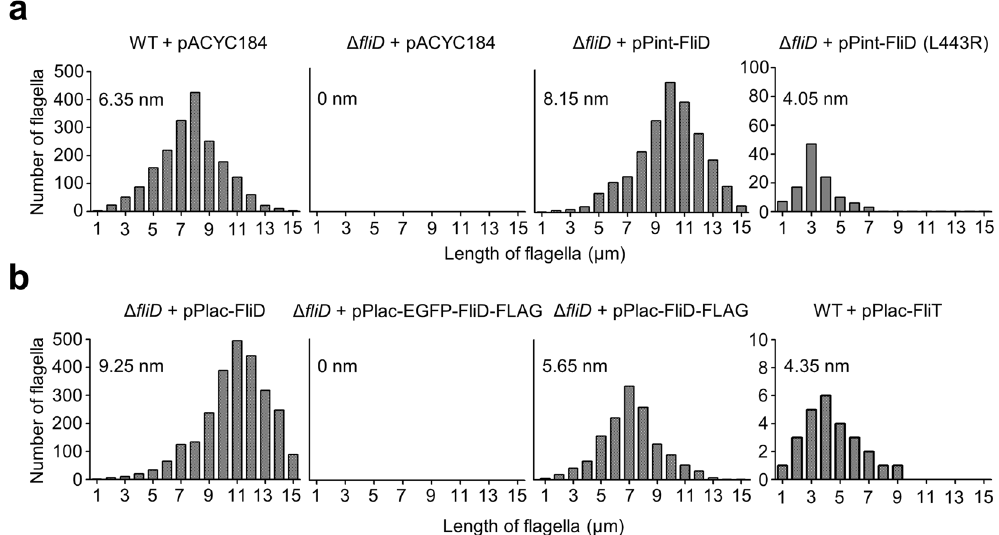
Figure 4. Histogram of filament length or flagella number in Salmonella strains. ( a , b ) Each strain with or without pPint-FliD, pPint-FliD (L443R), pPlac-FliD, pPlac-FliT, pPlac-EGFP-FliD-FLAG, or pPlac-FliD-FLAG was grown in LB medium to mid-log phase, and filament length or flagella number was measured. pPint-FliD and pPint-FliD (L443R) are pACYC184 derivatives expressing fliD or fliD (L443R) under the intrinsic promoter, while pPlac-FliD, pPlac-FliT, pPlac-EGFP-FliD-FLAG, and pPlac-FliD-FLAG are pUHE21-2 lacI q derivatives overexpressing fliD , fliT , EGFP- fliD -FLAG, or fliD -FLAG, respectively, under the lac